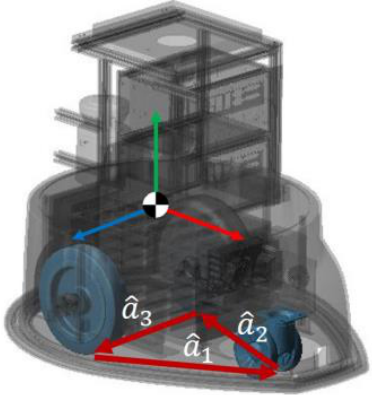
Figure 4. Tilting shape and platform COG.